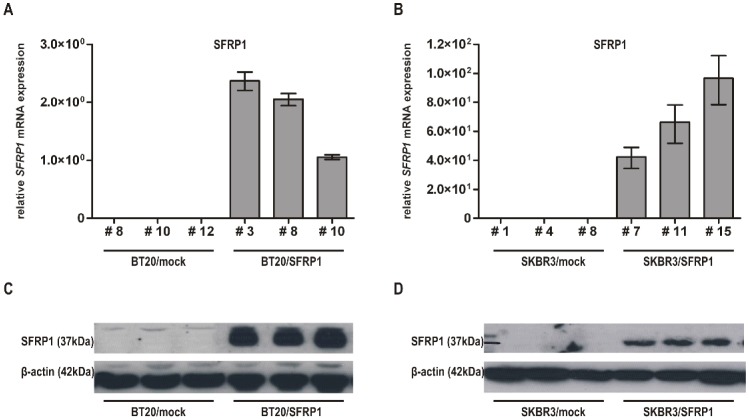
Generation of human breast cancer cell lines stably expressing SFRP1.Stable clones have been generated with a full-length SFRP1 cDNA or with empty pEF6/V5 vector control. (A) Semi-quantitative real-time PCR for SFRP1 re-expression was performed after transfection in BT20 and (B) SKBR3 cells. SFRP1 mRNA was only detectable in the SFRP1 clones. (C) Western blot analysis was performed on lysates of three BT20 and (D) SKBR3 mock and of three SFRP1 clones. SFRP1 protein expression increased remarkably after transfection with a SFRP1 expression vector compared to the corresponding mock vector. β-actin was used as a loading control.